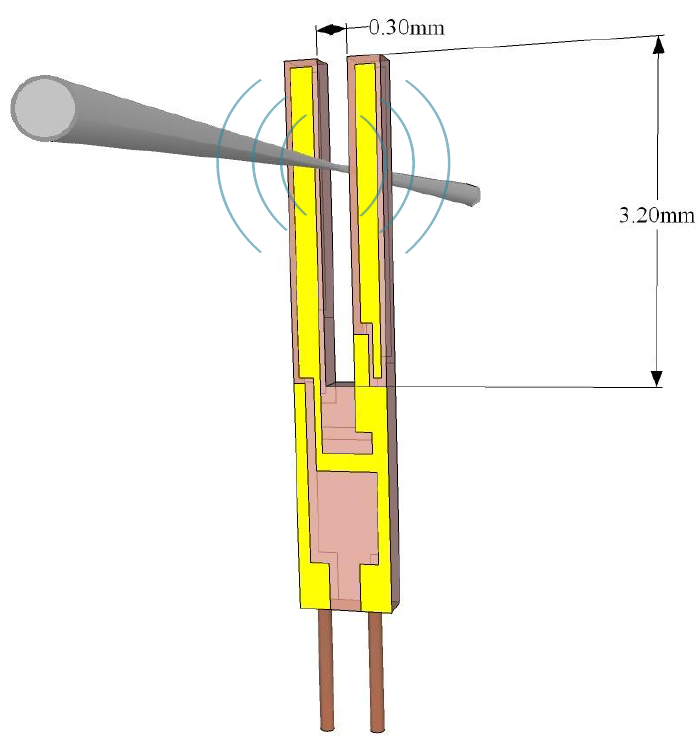
Figure 14. Schematic of the quartz-enhanced evanescent-wave PAS configuration with a tapered optical micro fiber. The green circular lines represent the wavefronts of the acoustic